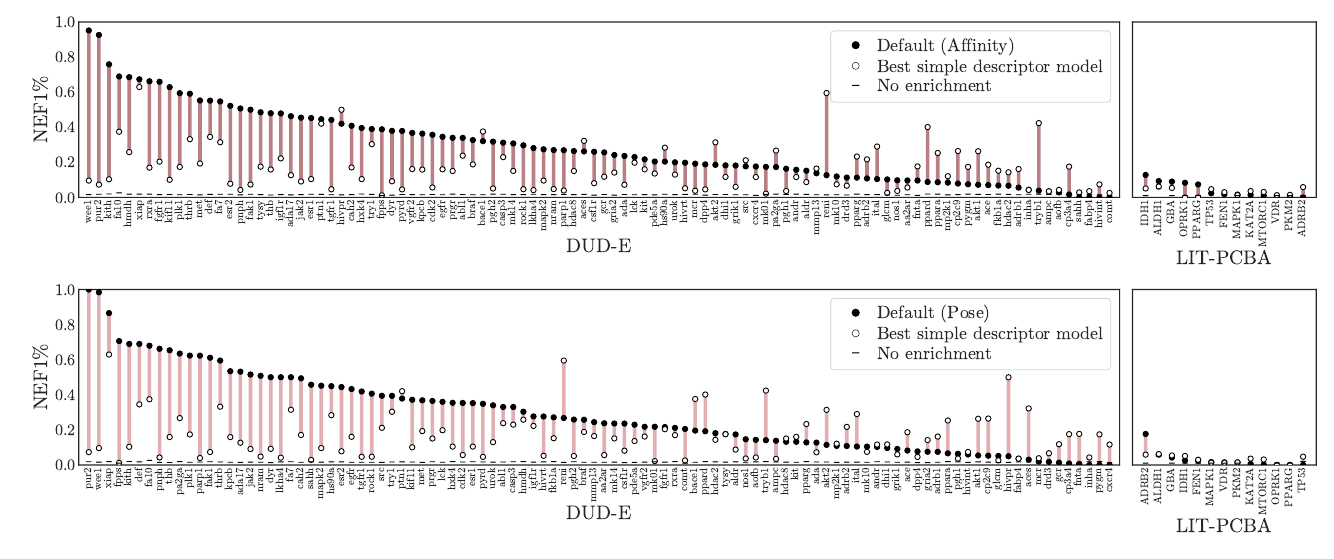
Figure 6. Comparison to simple descriptor models. The NEF1% for both the Default ensemble and the best performance achievable by a model fit to simple descriptors trained for affinity prediction on the PDBbind Refined set. Additional models and metrics are shown in Figures S22 and S23. The x -axes are sorted independently by the NEF1% of the best scoring pose.